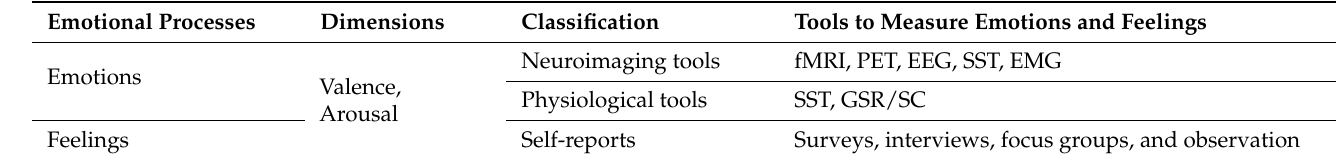
Table 2. Neuromarketing tools to measure emotions and